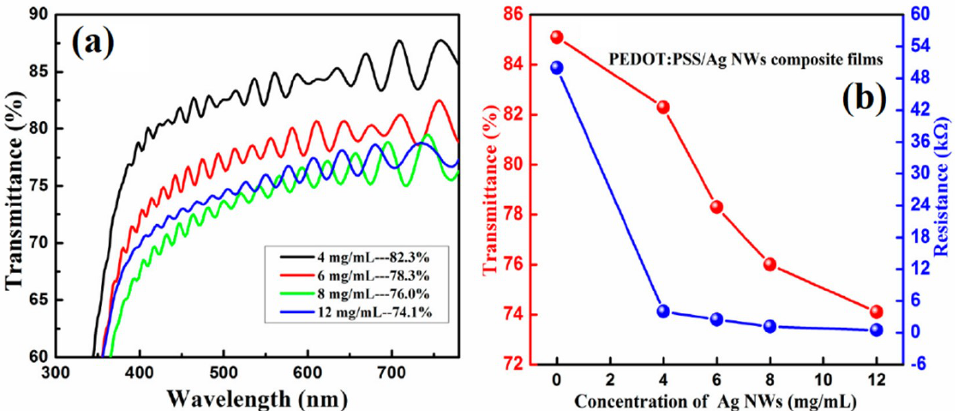
Figure 10. ( a ) Optical transmittance and ( b ) variation of the transmittance (at 550 nm) and resistance of PEDOT:PSS/Ag NW composite by increasing the concentration of Ag NWs filler from 4 to 12 mg/mL. Reproduced with permission from [32]. Copyright 2017 MDPI